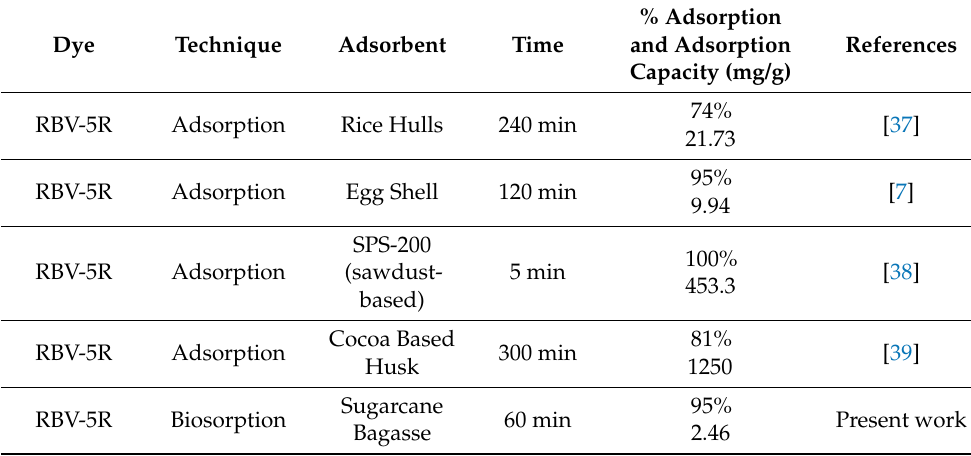
Table 2. Comparative analysis of the RBV-5R removal by SCB and other adsorbents.